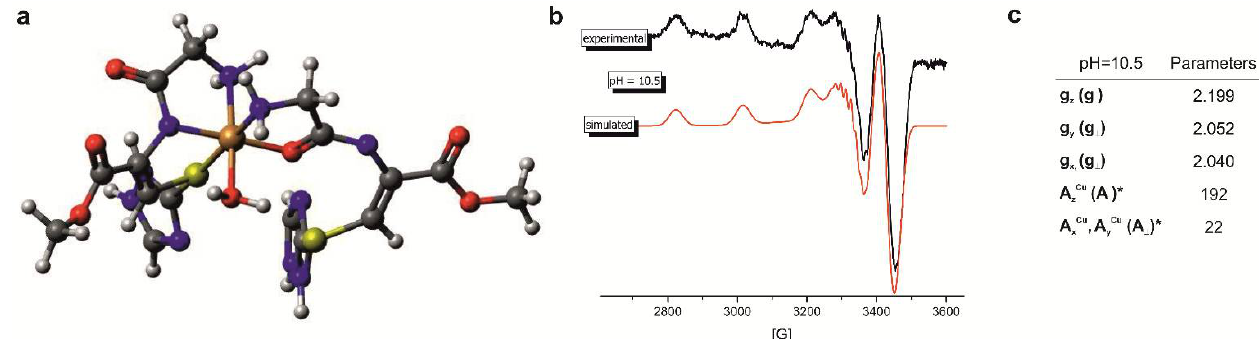
Figure 4. ( a ) The proposed binding mode of the 9a -Cu(II) in the complexes with the CuL 2 H x stoichiometry ( b ) the experimental and simulated EPR spectra and ( c ) parameters obtained for the 9a ligand in the system with nL:nCu(II) = 2:1 molar ratio and pH = 10.5.